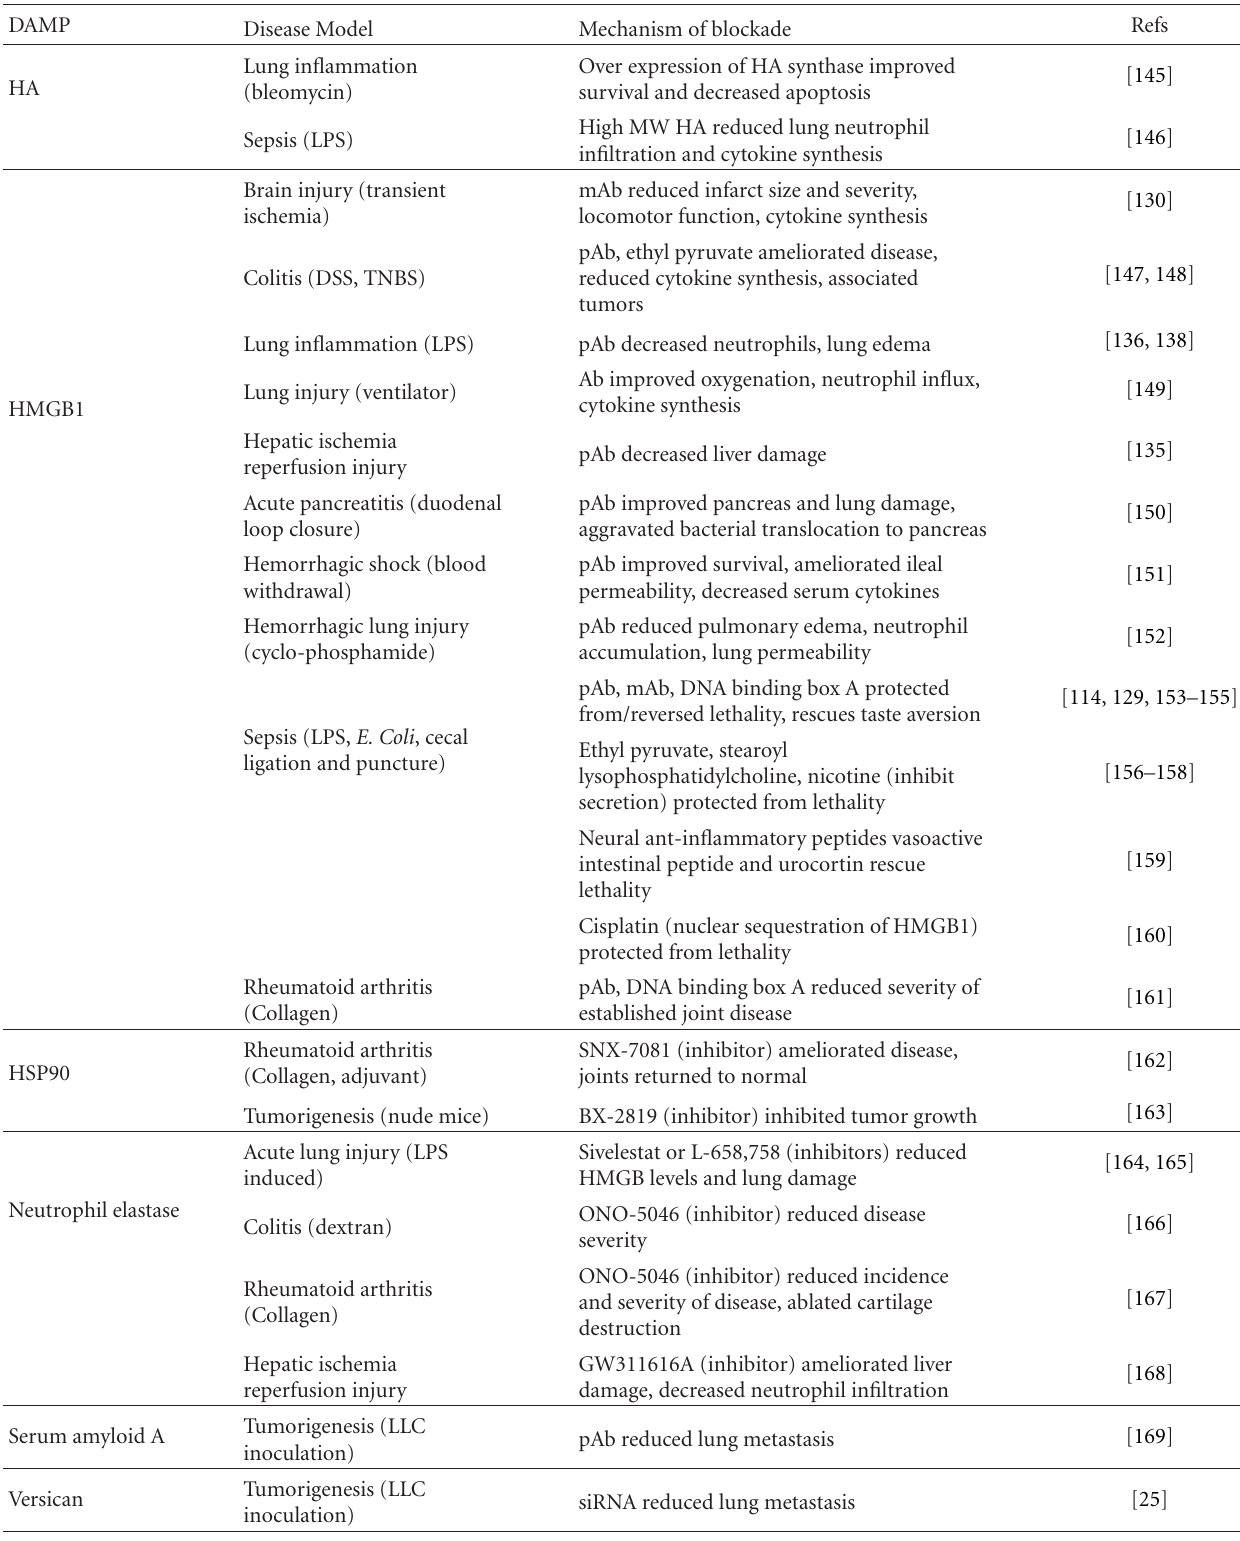
Table 3: Manipulation of DAMP function ameliorates experimental disease . Therapeutic blockade of DAMP function, for example, using monoclonal or polyclonal antibodies (mAb, pAb) or specific inhibitors or silencing DAMP expression by siRNA can reduce disease progression in vivo